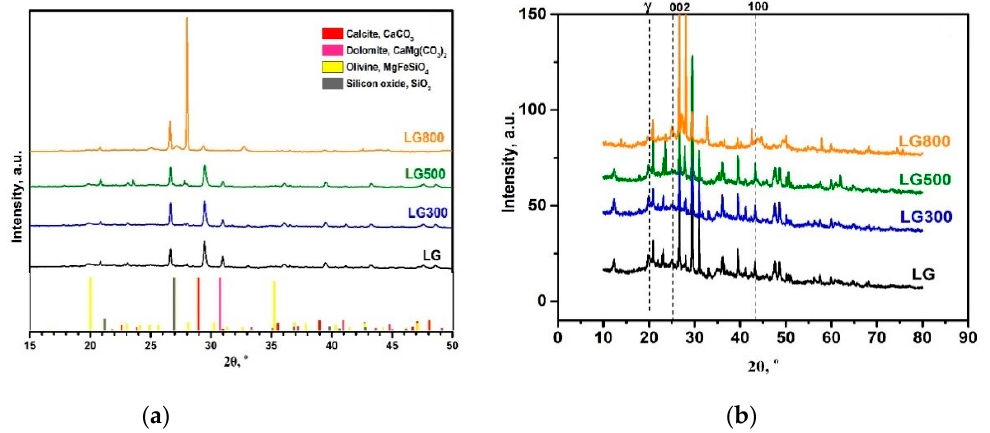
Figure 1. XRD patterns of pristine lignite and as-produced chars ( a ), closer inspection of XRD pat- terns ( b ).